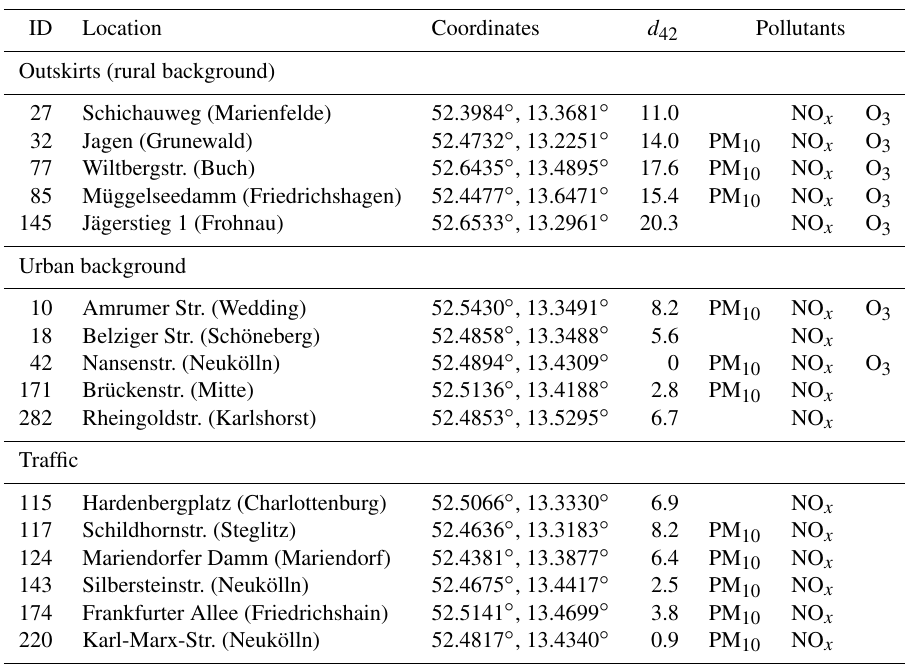
Table 1. Automatic stations of the BLUME network of Berlin. Names of the locations with the corresponding district are given in parentheses. Coordinates are given as latitude (degree north) and longitude (degree east); d 42 is the distance (in km) from station 42 (Nansenstraße). Listed are only measurements of pollutants discussed in this